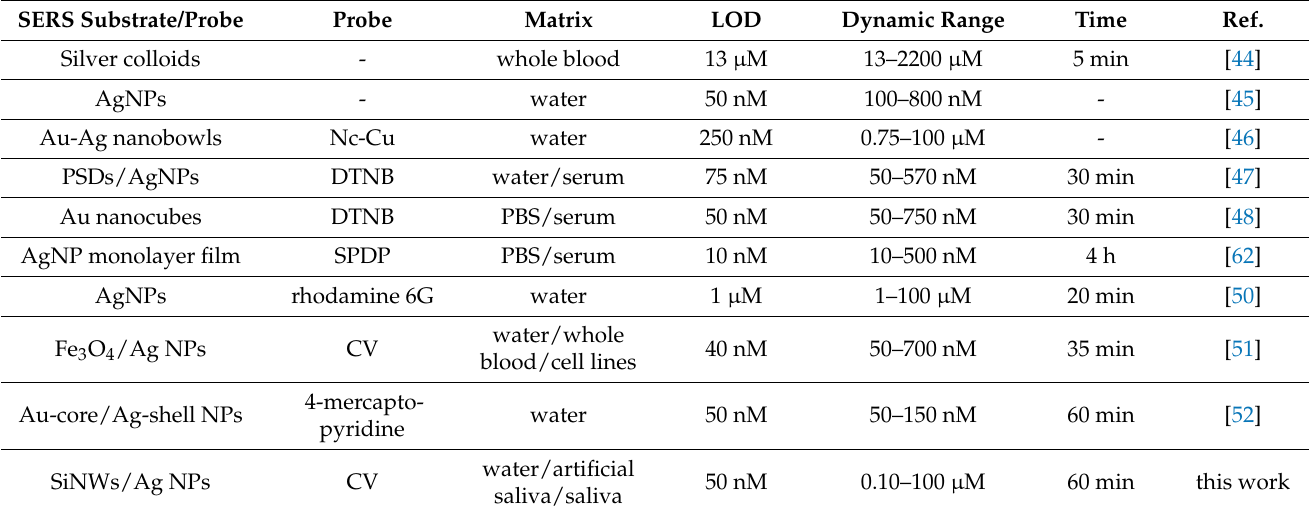
Table 1. Comparison of GSH detection methods with